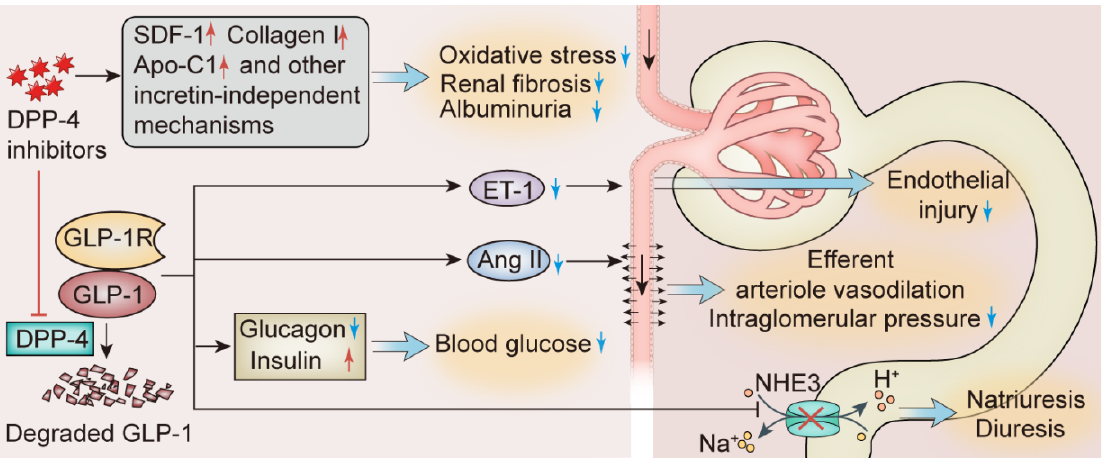
Figure 2. The renoprotective mechanisms of DPP-4 inhibitors. DPP-4 inhibitors can exert renopro- tective effects dependent on or independent of the incretin. GLP-1, an identified incretin, works by the activation of GLP-1R. GLP-1 is rapidly degraded by DDP-4 after exerting its effects. After inhibiting the degradation of GLP-1, DPP-4 inhibitors resulted in decreased blood glucose, improved hypertension by inhibiting Ang II, protected endothelial function by inhibiting ET-1, and inhibited NHE3 to exert natriuretic effect. On the other hand, DPP-4 inhibitors inhibited oxidative stress and improved renal fibrosis by regulating SDF-1, collagen I, Apo-C1 and other substrates independent of GLP-1 and its receptors. DPP-4, dipeptidyl peptidase-4; GLP-1, glucagon-like peptide 1; GLP-1R, glucagon-like peptide 1 receptor; SDF-1, stromal cell-derived factor 1; Apo-C1, apolipoprotein C1; Ang II, angiotensin II; ET-1, endothelin-1; NHE3, sodium-hydrogen exchanger 3. Upper arrow in red indicates increase; down arrow in blue indicates decrease; down arrow in black indicates the direction of blood flow.